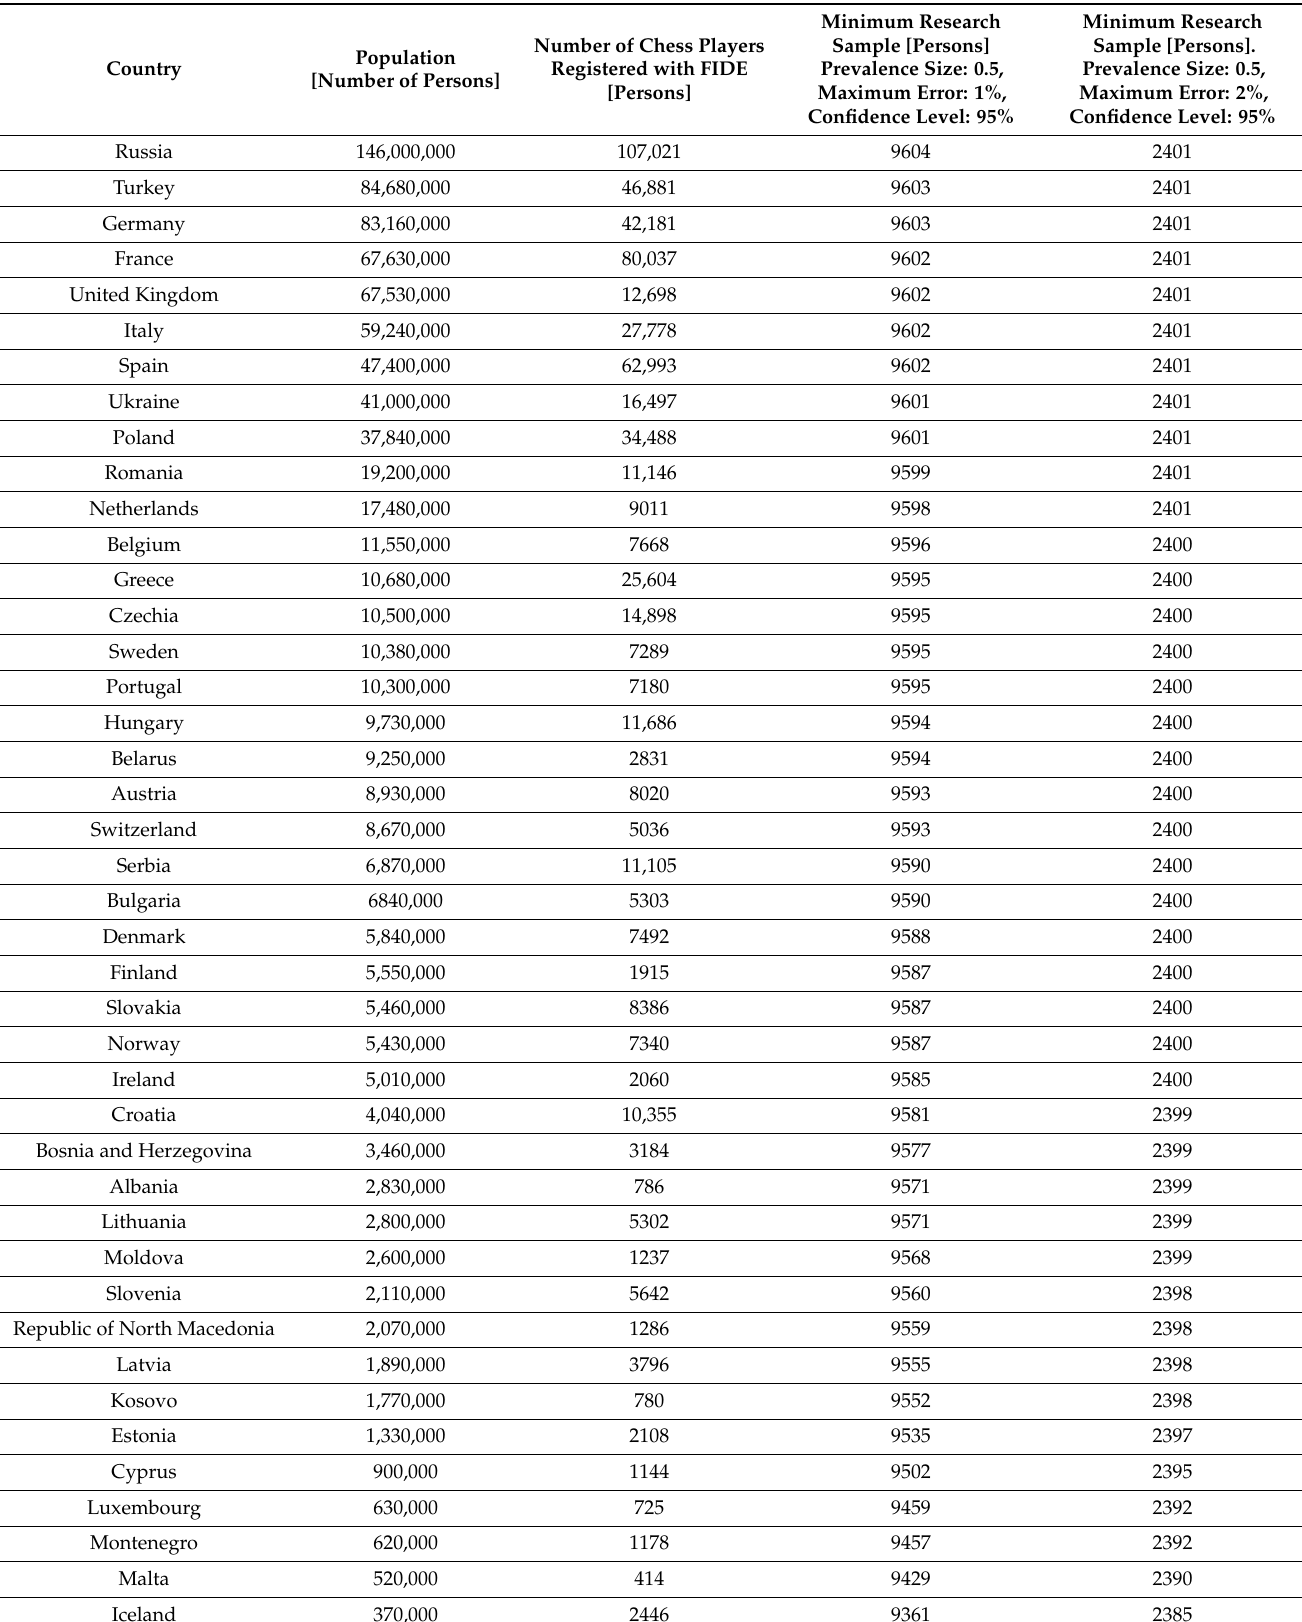
Table 1. Population in each European country and minimum research sample